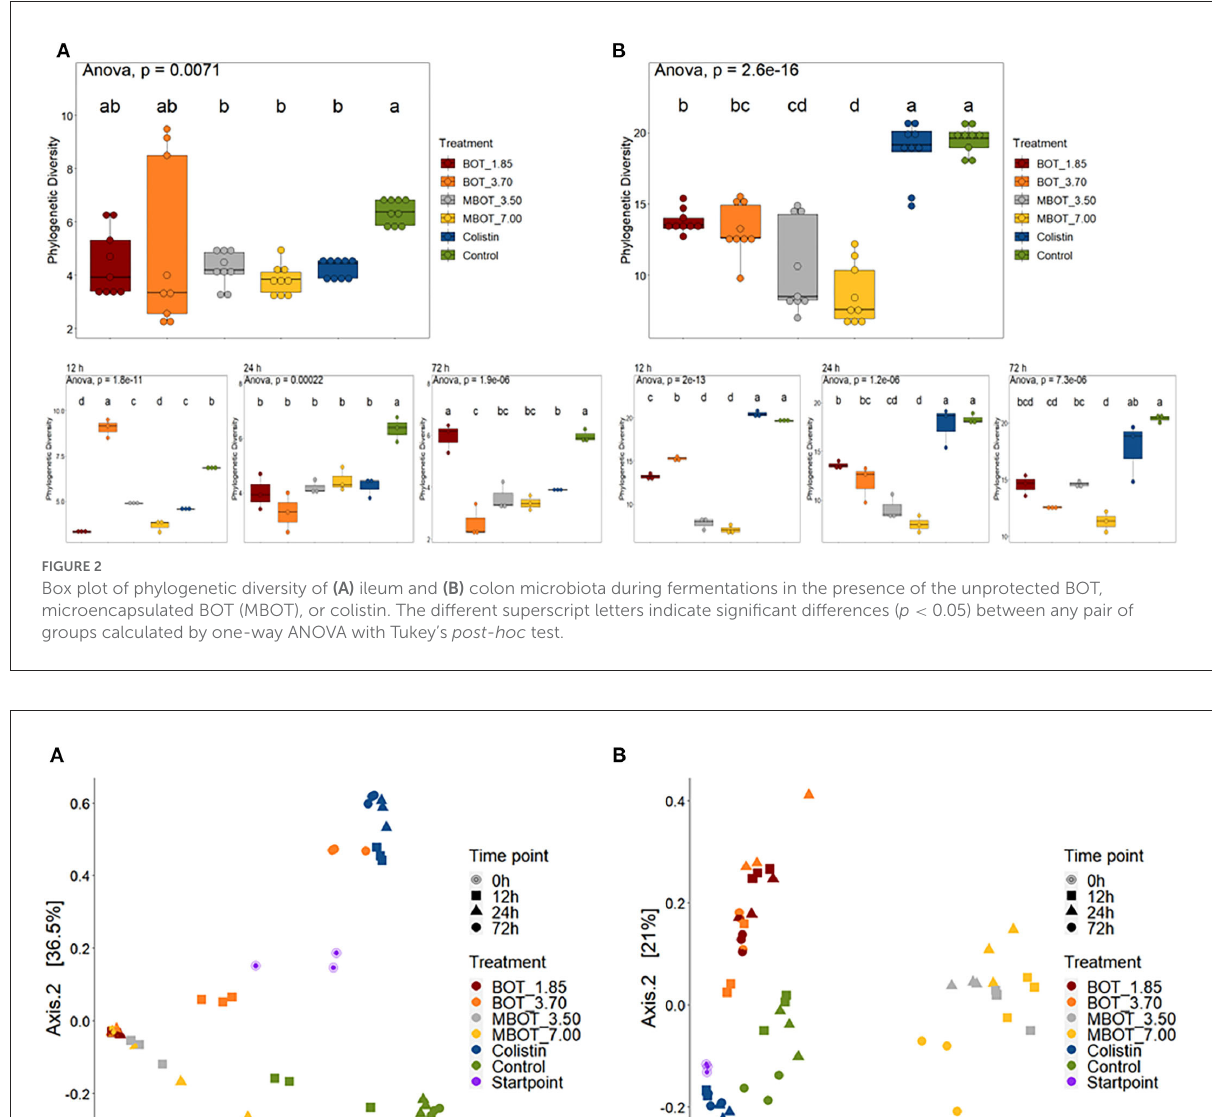
lower when compared with the control. Furthermore,